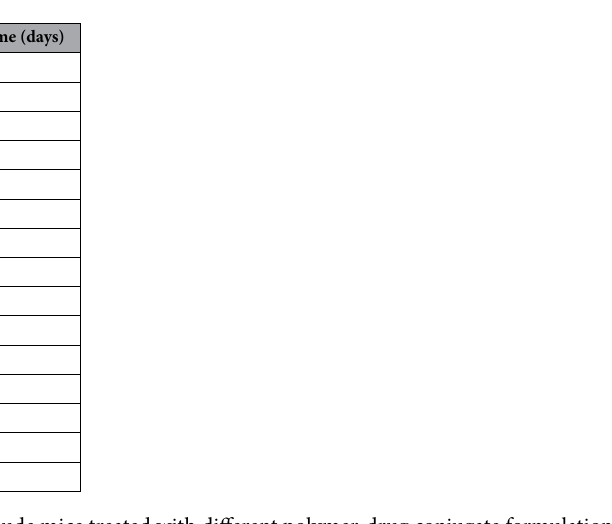
Table 4. Survival time of the xenograft nude mice treated with different polymer-drug conjugate formulations. Data were given as mean ± SD (**p <0.05).